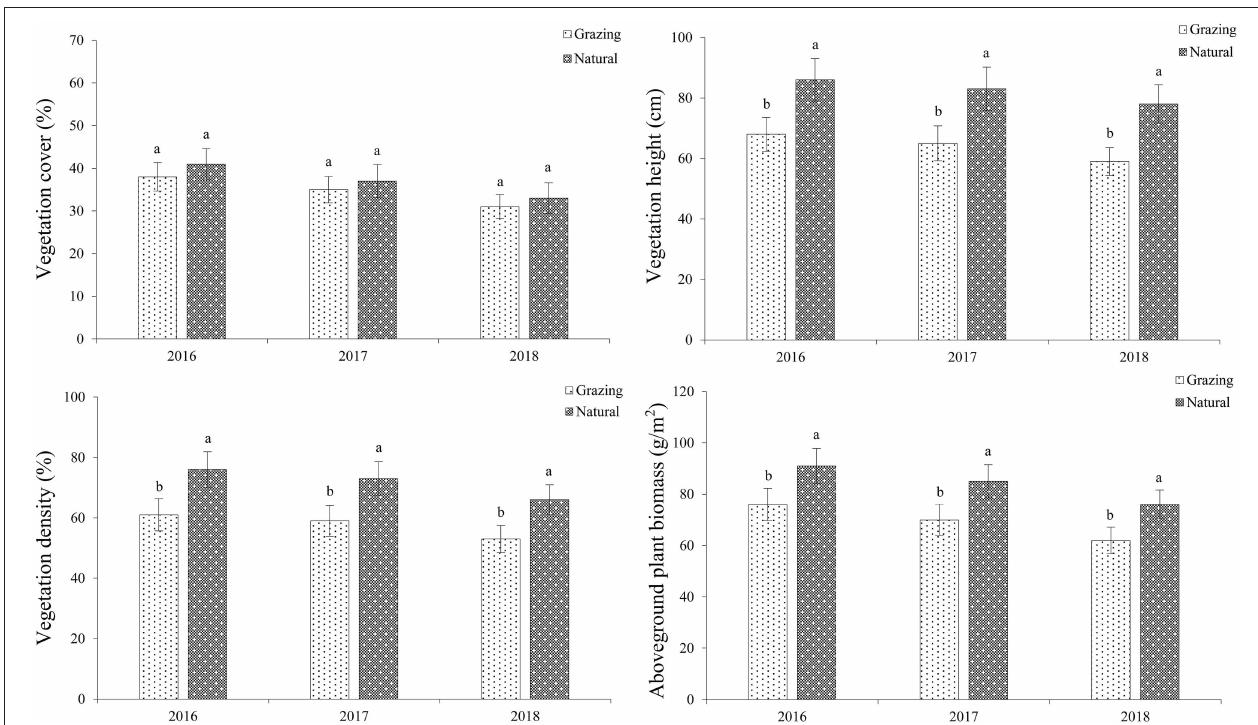
FIGURE 2 | Grazing effects on vegetation in both habitats. Vegetation cover (VC), vegetation density (VD), vegetation height (VH), and aboveground plant biomass (AGB) of C. microphylla .